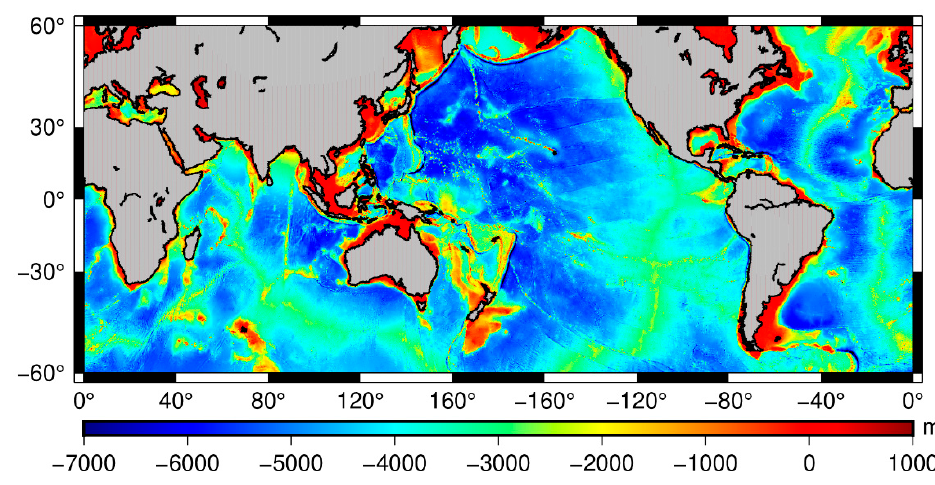
Figure 7. Global bathymetry model HY2ONLY_BAT. Table 2. Precision statistics of bathymetry model errors without removing gross errors.